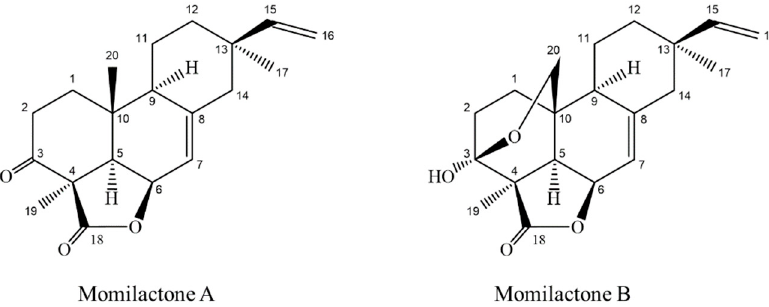
Figure 1. Structures of momilactone A and momilactone B [6,7].